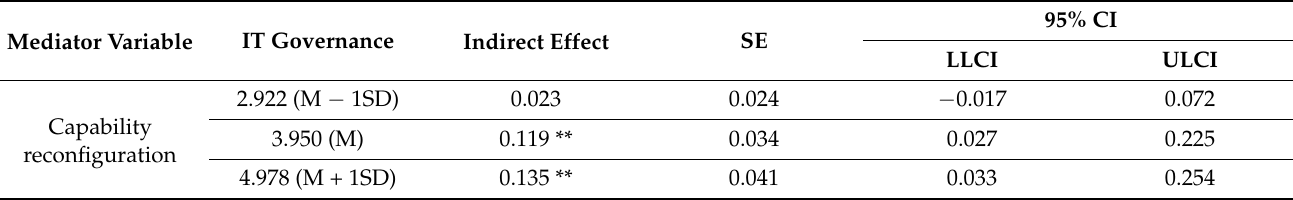
Table 6. Moderated mediating effect test with bootstrap